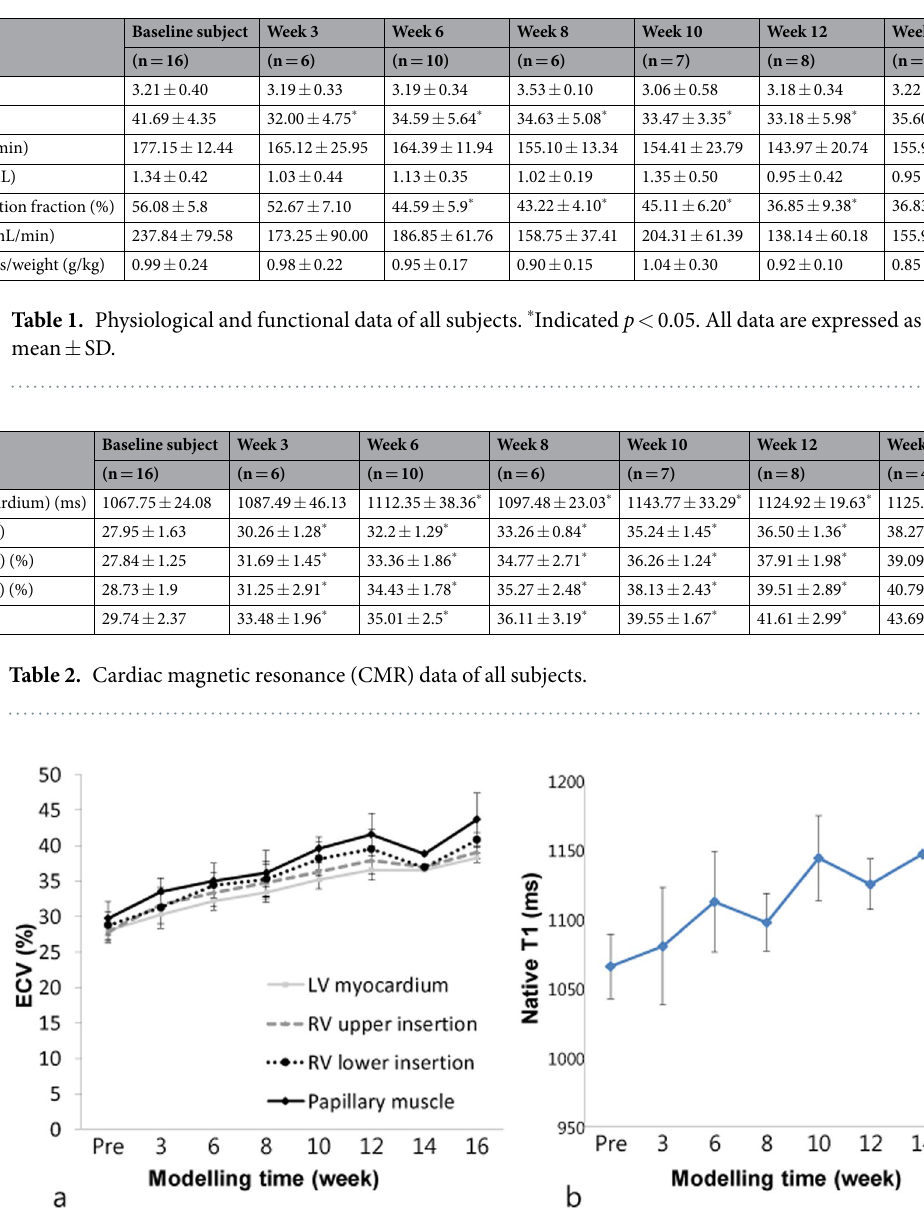
Figure 2. Serial changes in the extracellular volume (ECV) and native T1 values. ( a ) Serial changes in the ECVs of the left ventricle (LV) myocardium and other specific LV lesions according to modelling time. The mean ECV of the mid-LV increased significantly beginning at 3 weeks ( p = 0.002). Compared with the LV myocardium, the ECVs of the right ventricle (RV) upper and lower insertion sites and the papillary muscle were higher. ( b ) Serial changes in the native T1 values of the LV myocardium according to modelling time. Mean native T1 values at the mid-LV increased significantly beginning at week 6 ( p <